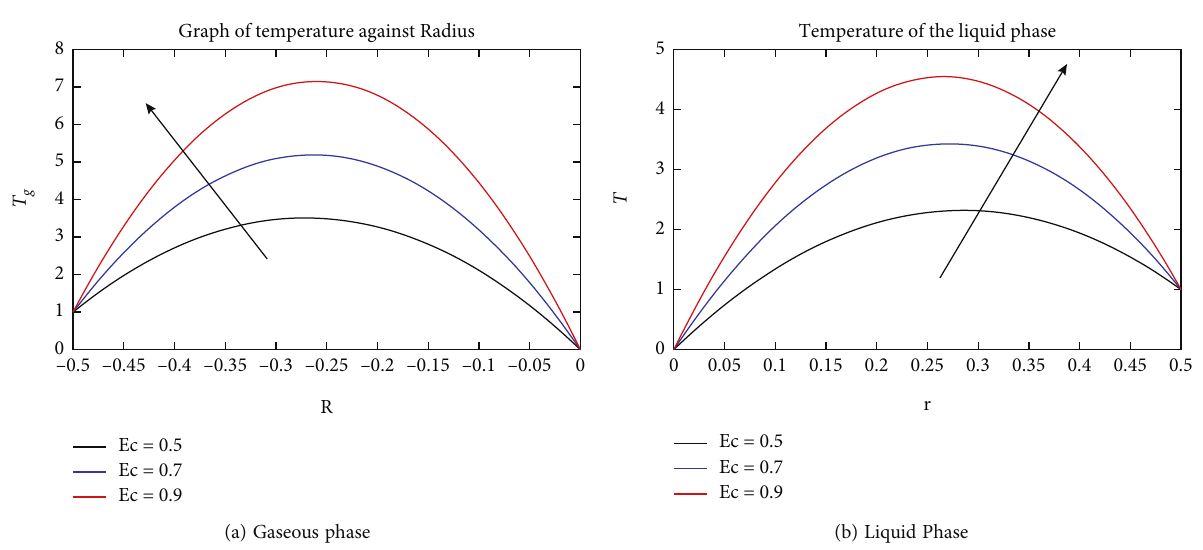
on Temperature. e